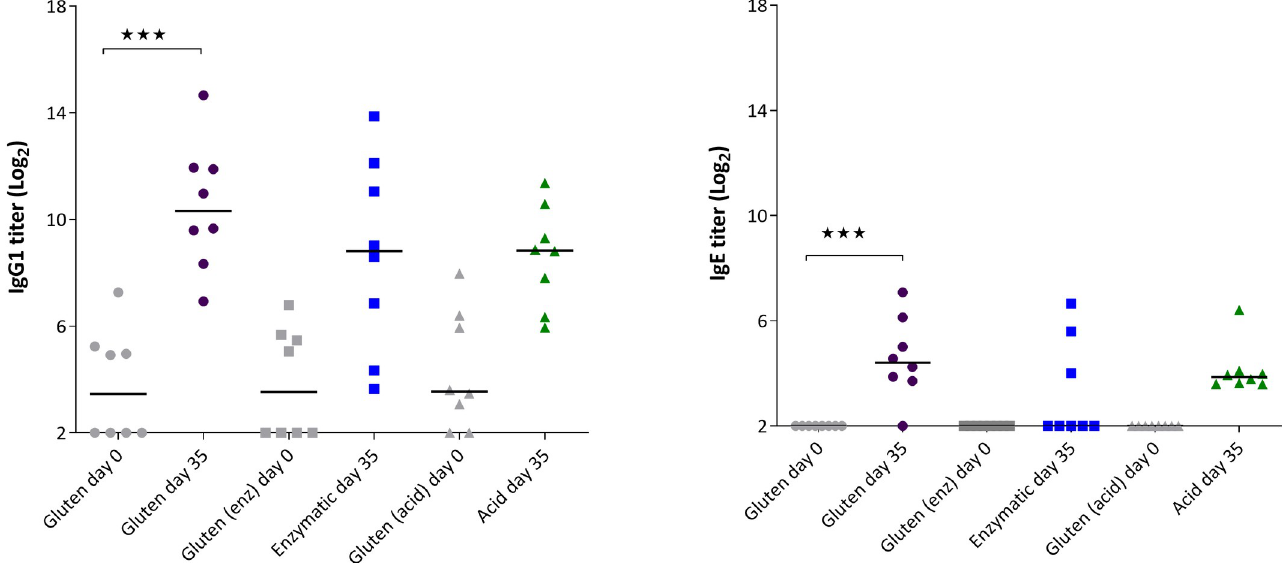
Fig 1. Specific antibody (IgG1 and IgE) responses to gluten at baseline (day 0) and to the respective antigens day 35 after three i.p. immunizations of gluten tolerant rats with gluten, enzyme or acid hydrolyzed gluten. ��� p < 0.001.